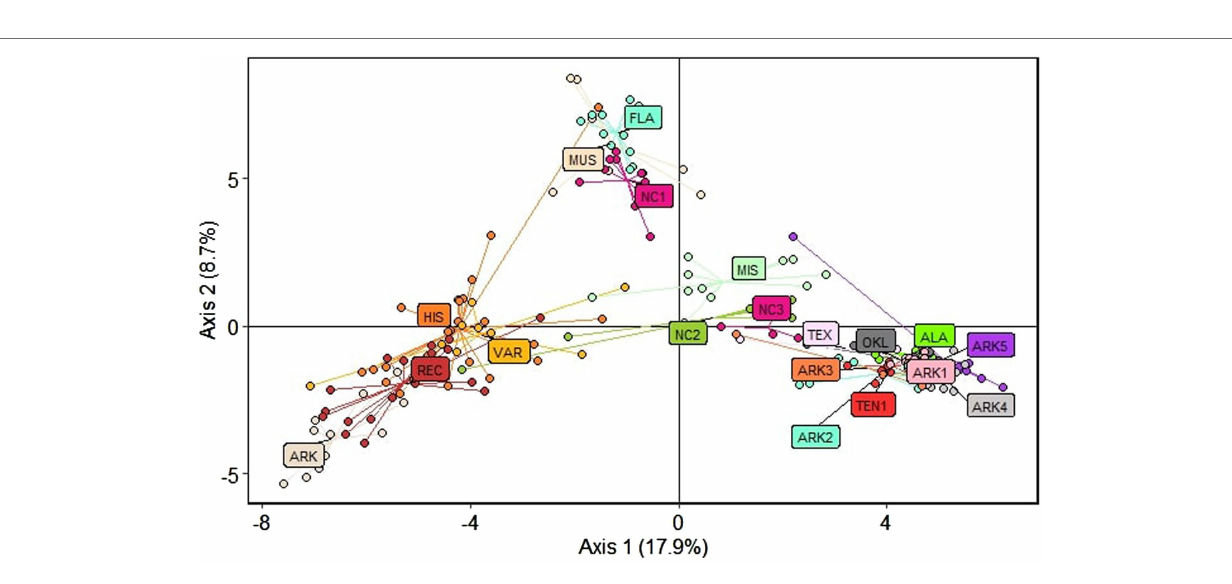
FIGURE 3 | Principal component analysis (PCA) showing the three distinct clusters of material used in this study. Each point is color coded according to its respective